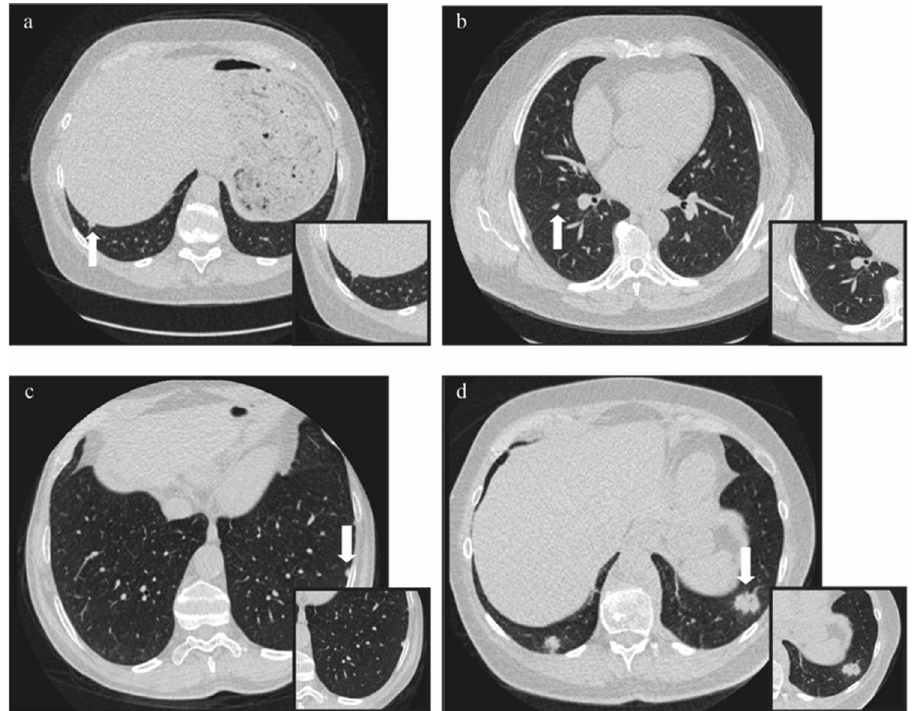
Figure 2. Transverse CT images of detected lung nodules in four ImaLife participants. Lung nodules indicated by white arrows, with zoomed-in view in the left bottom. ( a ) Solid, 136 mm 3 , oval, smooth edged, non-calcified, peripheral lung nodule, in the right lower lobe posterior basal segment. ( b ) Solid, 132 mm 3 , triangular, smooth edged, non-calcified, peripheral lung nodule which was categorised as a typical perifissural nodule (PFN), in the right lower lobe apical segment. ( c ) Solid, 154 mm 3 , triangular, smooth edged, non-calcified, peripheral lung nodule which was categorised as an atypical PFN, in the left lower lobe lateral basal segment. ( d ) Solid, 3933 mm 3 , irregular shaped, irregular edged, non-calcified peripheral nodule, situated in the left lower lobe anterior